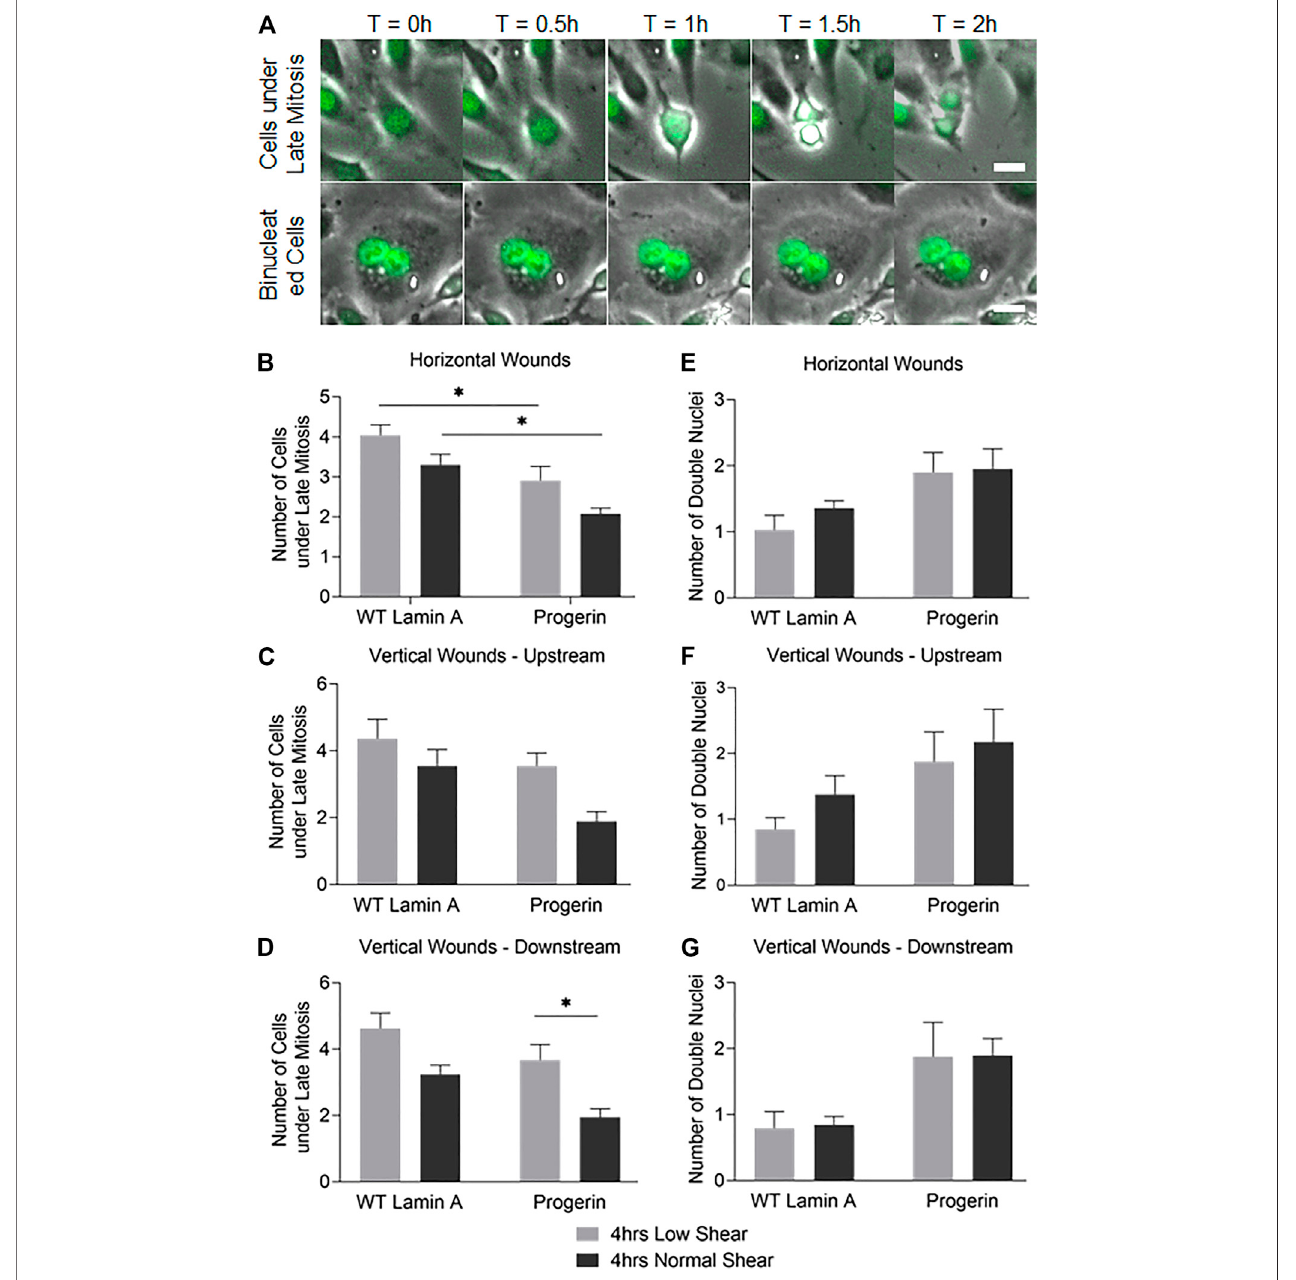
FIGURE 6 | (A) Examples of cells under late mitosis that were recognized by nuclear expansion and separation ( fi rst row), as well as cells containing double nuclei and were not followed by cytokinesis (second row) during the fi rst 2 h following fl ow application. Scale bar: 20 µm. (B – G) Quanti fi cations of cells that were undergoing late mitosis (B – D) or contained double nuclei (E – G) within the fi rst 4 rows at horizontal or vertical wound edges (upstream and downstream as to fl ow) after fl ow application. * p < 0.05.